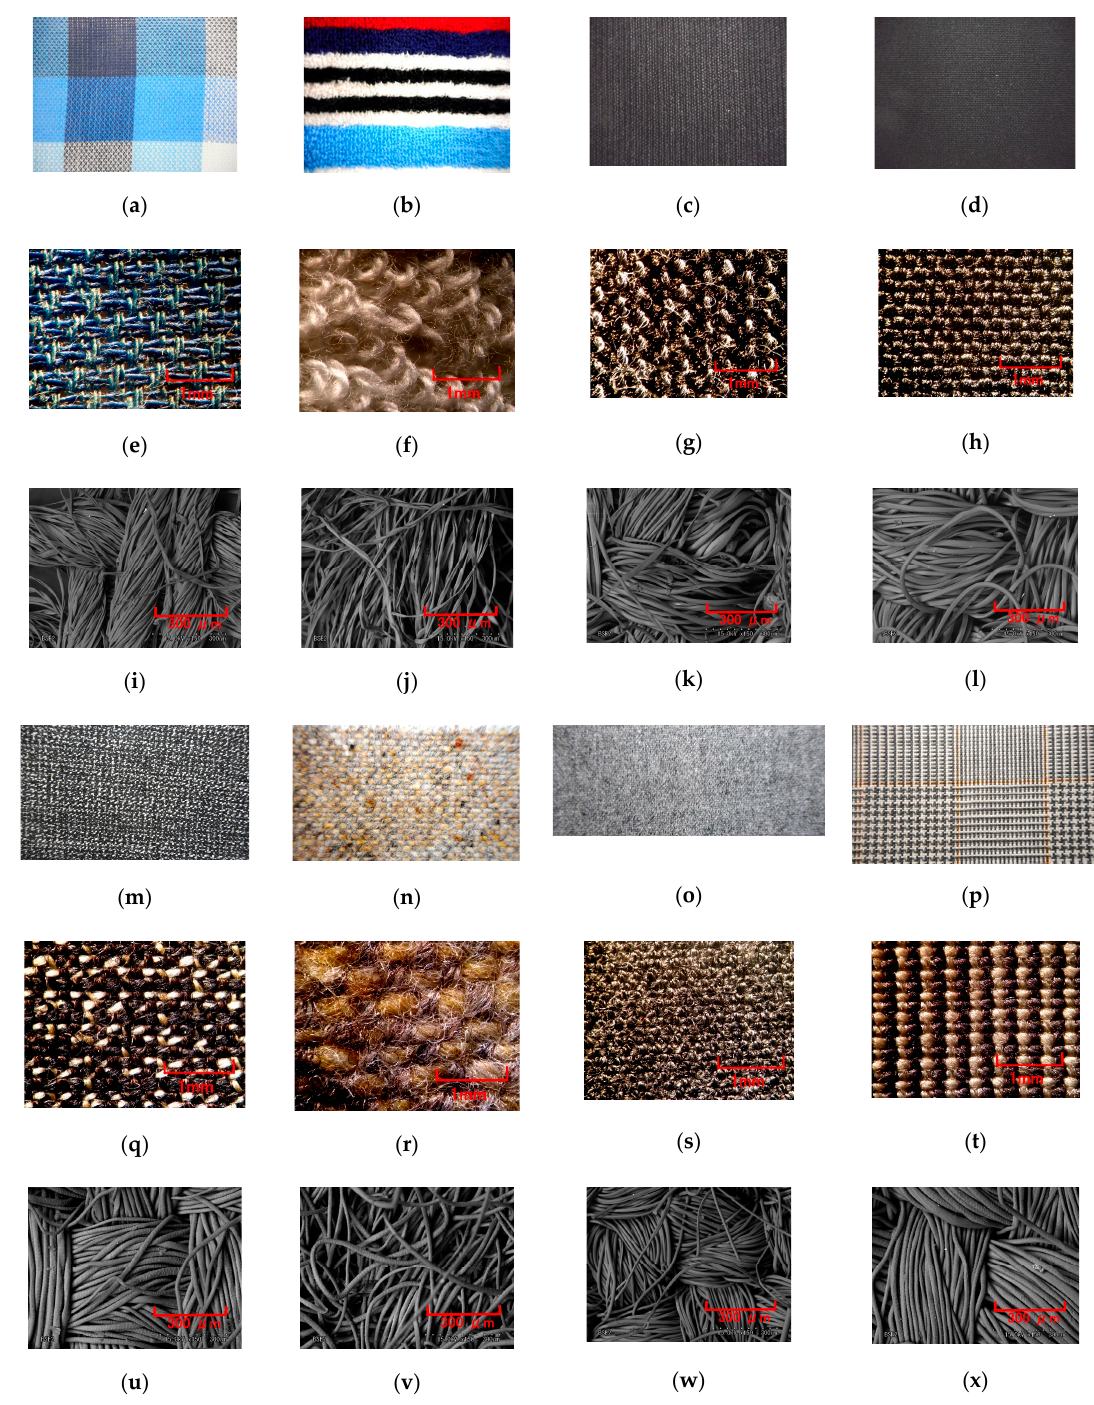
Figure 17. Images of various cloths rubbed by the MCF rubber sensor: ( a ) handkerchief; ( b ) washcloth; ( c ) cloth of trousers; ( d ) jacket for women; ( e ) and ( i ) microscopic image of A; ( f ) and ( j ) microscopic image of B; ( g ) and ( k ) microscopic image of C; ( h ) and ( l ) microscopic image of D; ( m ) E cloth of jacket for men; ( n ) F cloth of business suit for men in the winter; ( o ) G cloth of trousers for women; ( p ) H cloth of business suit for men in the summer; ( q ) and ( u ) microscopic image of E; ( r ) and ( v ) microscopic image of F; ( s ) and ( w ) microscopic image of G; ( t ) and ( x ) microscopic image of H; ( e )–( h ) and ( q )–( f ) by optical microscope; ( i )–( l ) and ( u )–( x ) by SEM with 150 magnification.